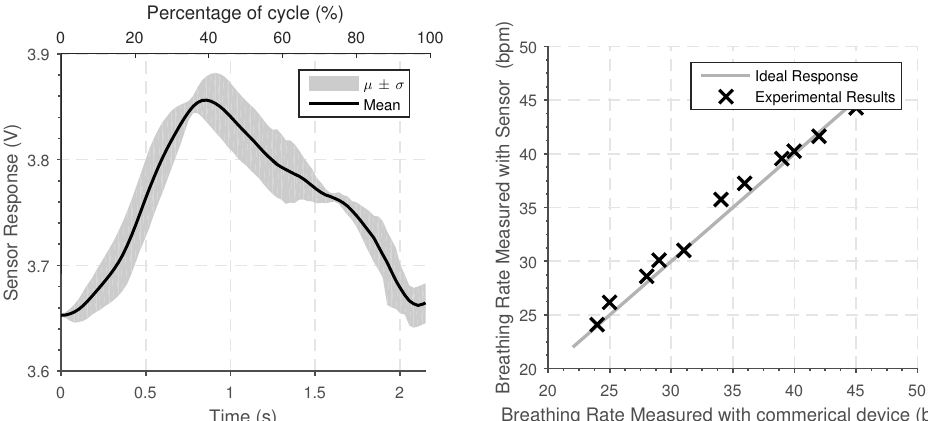
Figure 8. ( Left ) Average sensor response for the sensor when worn around the chest to measure breathing rate for a two-minute period. ( Right ) Experimentally measured breathing rate measured over a thirty-second period and the breathing rate determined by a commercial measurement system